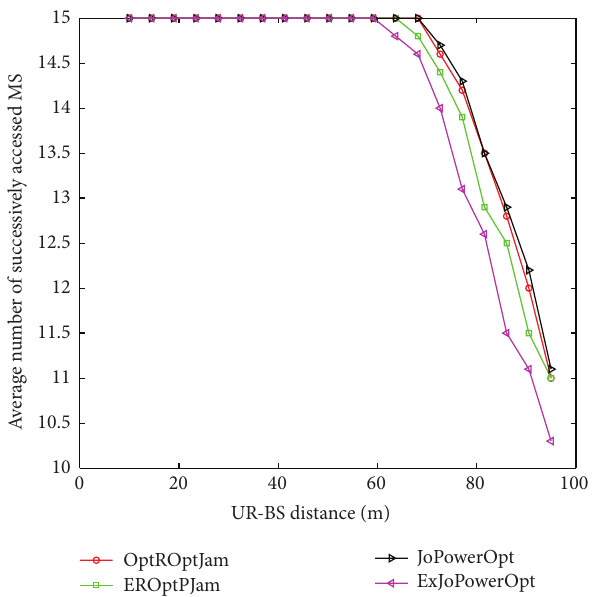
Figure 7: System sum secrecy rate versus number of